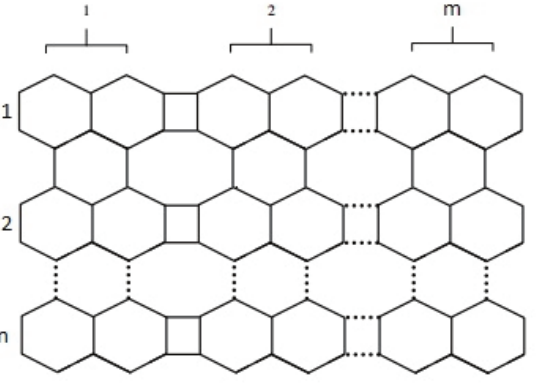
Figure1: Graph of H-Naphtalenic nanosheet H[m,n].